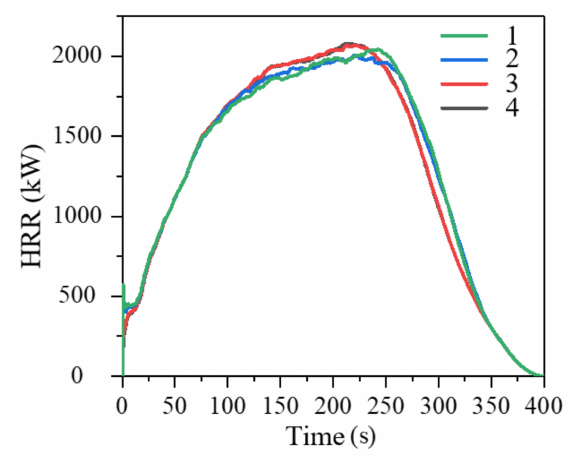
Figure 5. Heat release rate trend chart for different mesh